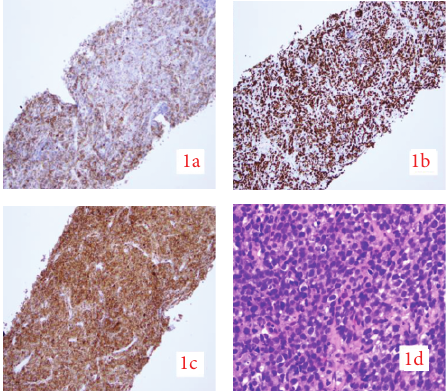
Figure 2: Liver Biopsy shows (1a) CD 20 positive on IHC. (1c) CD 10 positive on IHC. (1b) Ki 67 of 100% (1d)